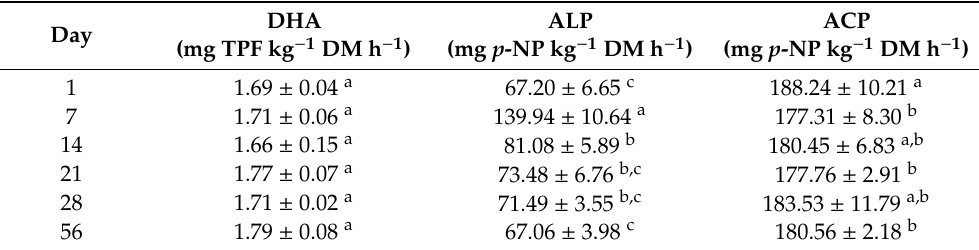
Table 5. Activity of soil enzymes in uncontaminated